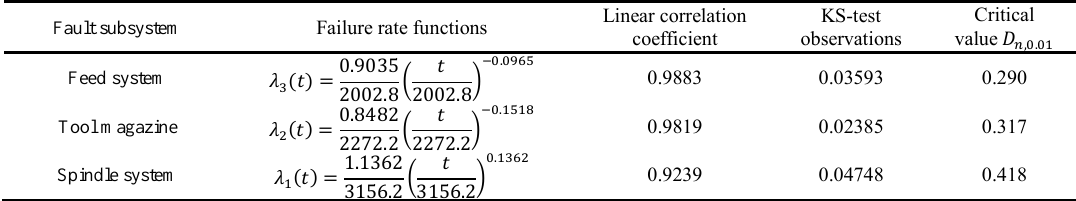
Table 2. Failure rate functions of key